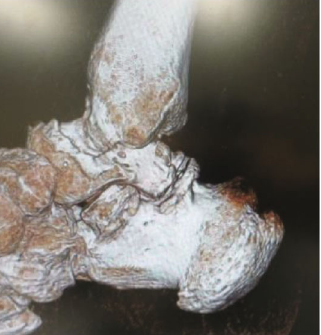
Figure 7: Histology slide showing peripheral chondrocytes.